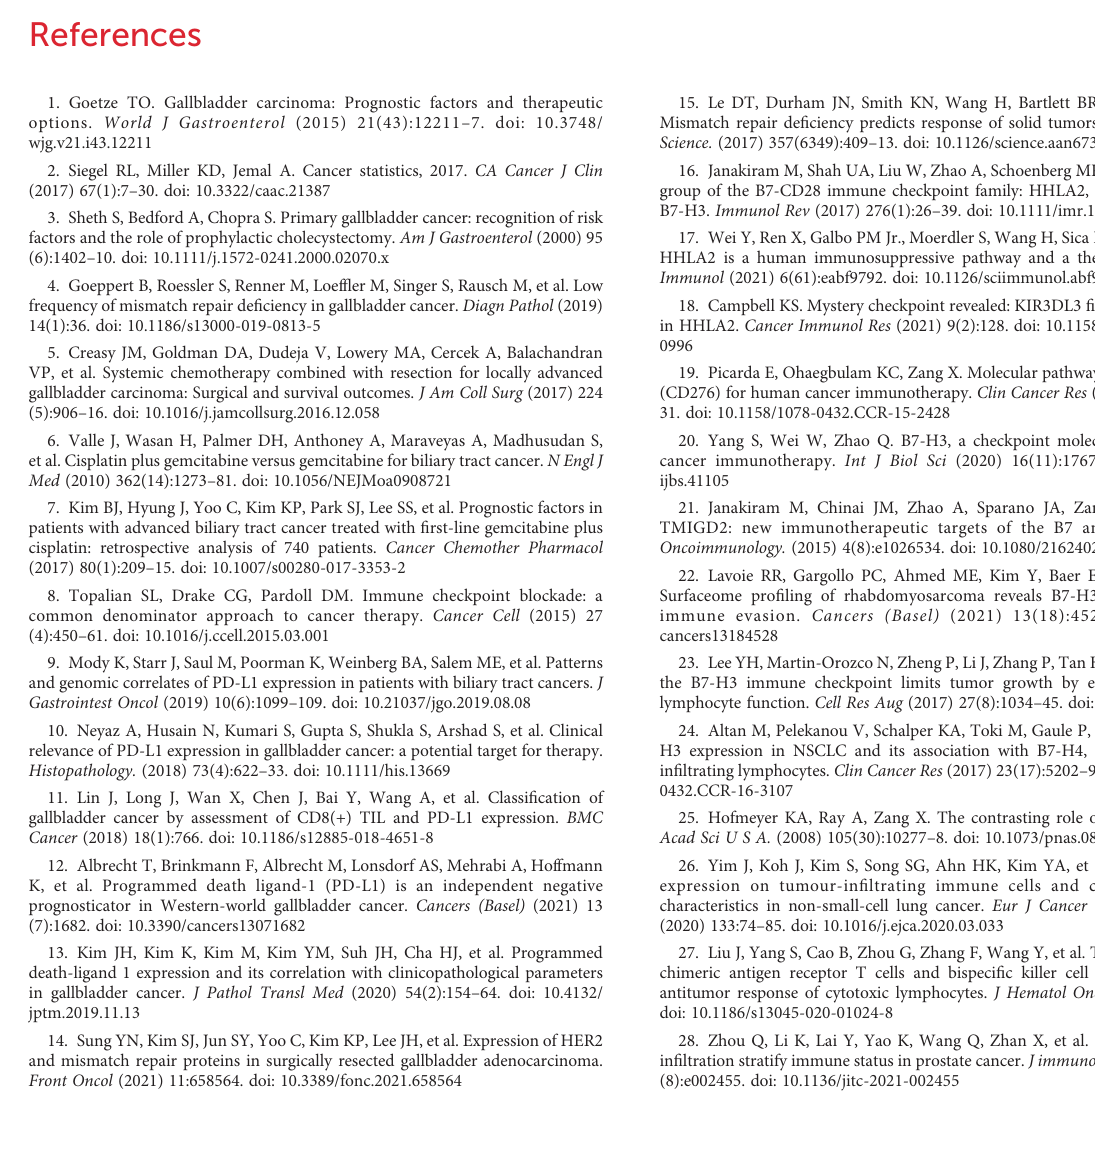
of the B7-Nevin model in the internal validation; (C) The calibration curve of the B7-Nevin model in the external validation; (D) Immune-Nevin model in the internal validation; (F) The calibration curve of the Immune-Nevin model in the external validation. SUPPLEMENTARY FIGURE 4 Instructions for the dynamic nomogram of the B7-TNM prediction model on the webpage, Linkage to https://dynnomo-for-gallbladder-cancer. shinyapps.io/DynNomapp-B7_TNM_model/.